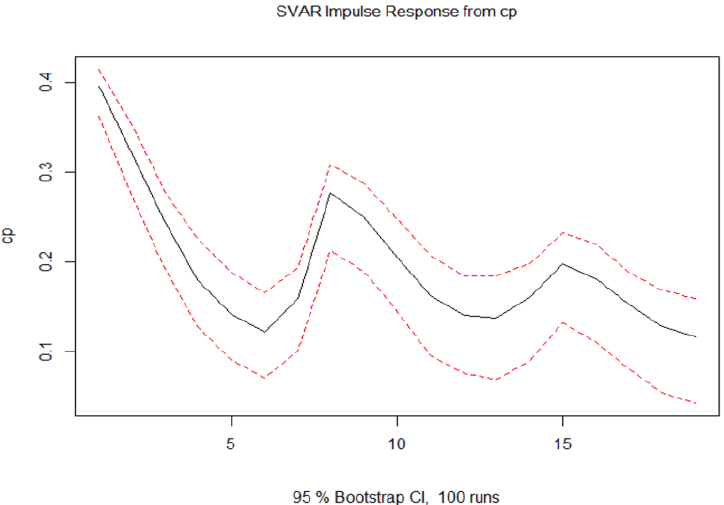
Figure 3: The SVAR Impulse Response of corona panic index from its’ lagged past values; Sources: Author’s compilation